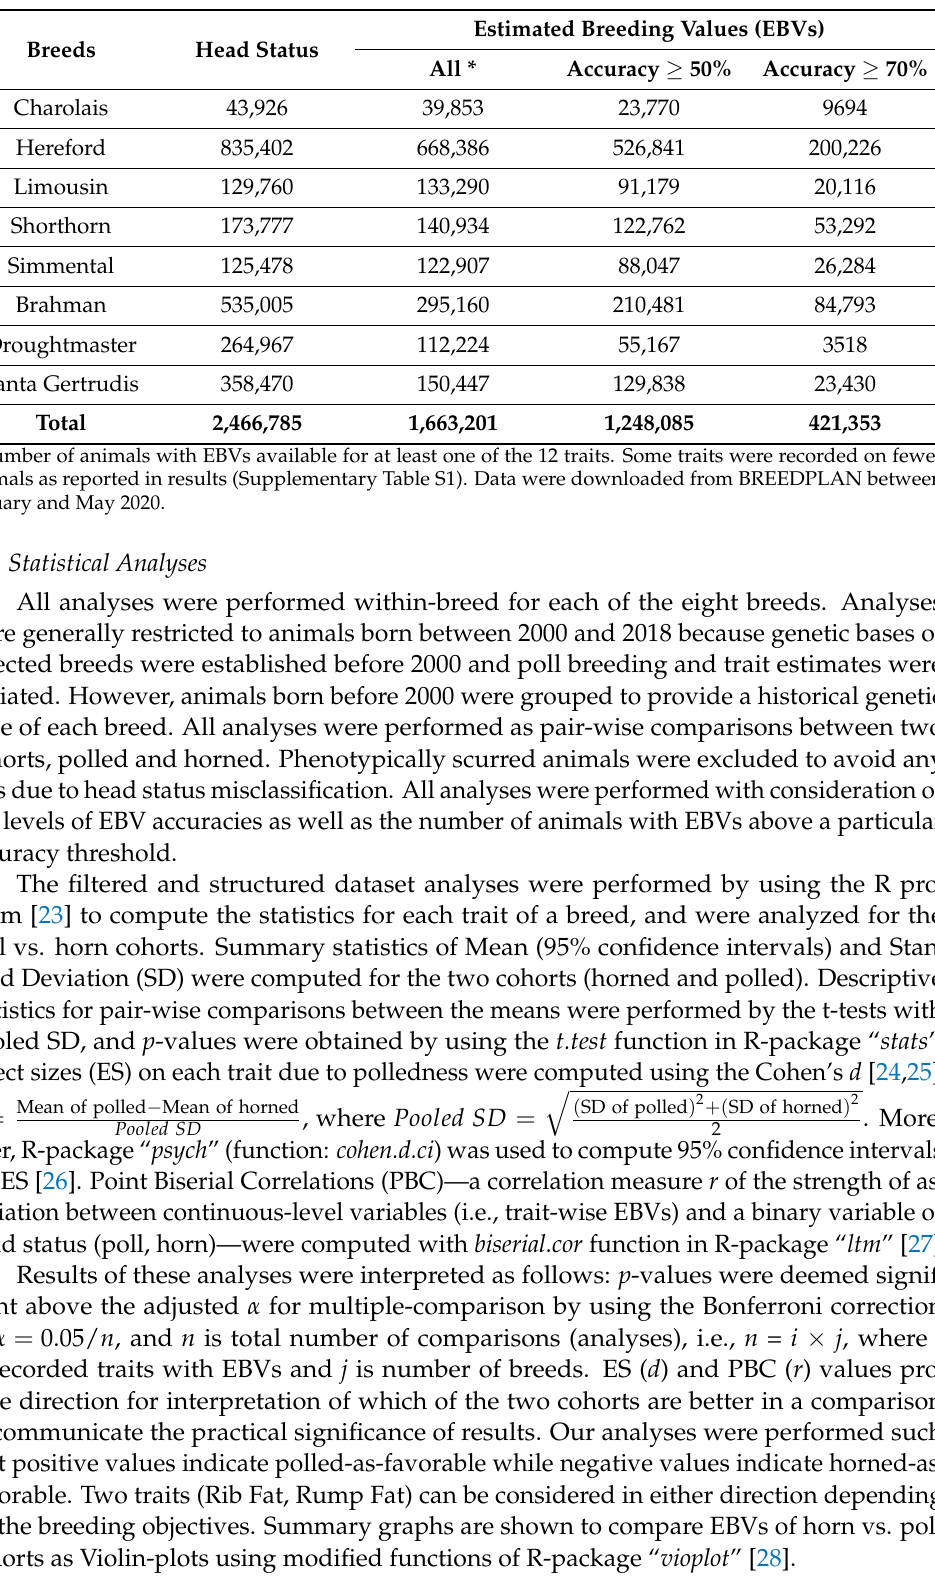
Table 1. Number of animals with known head status and estimated breeding values (EBVs) data of eight